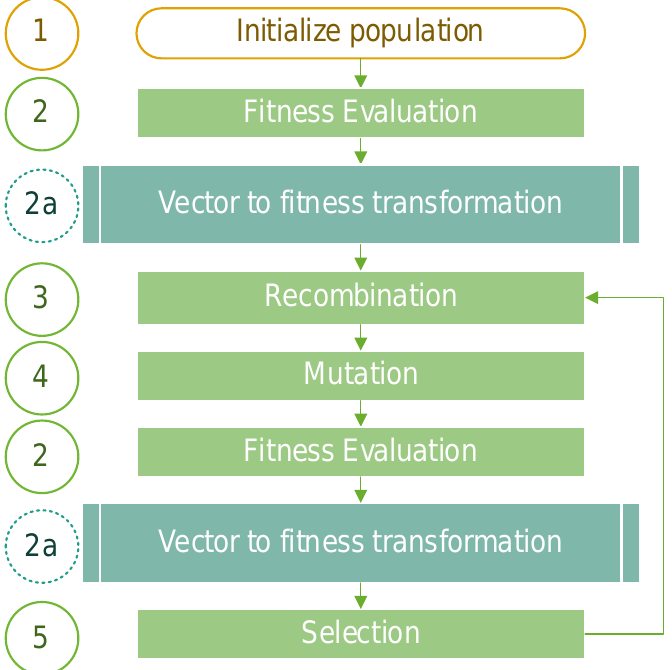
Figure 1. Sequential task decomposition for MOEA.